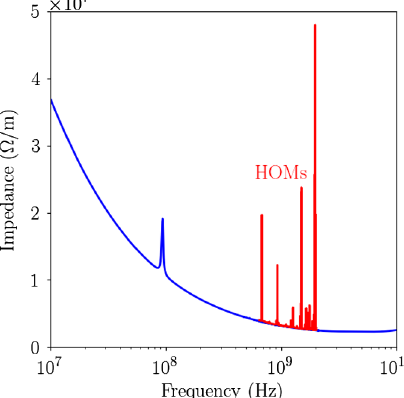
modes.FIG. 1. Higher order modes of the crab cavities (shown in red) dominate the HL-LHC transverse impedance (blue line) at the frequencies around 1 GHz. Real part of the horizontal dipolar impedance is plotted vs frequency for the ultimate scenario at the top energy of E ¼ 7 TeV. β (cid:1) ¼ 41 cm, 4 cavities per IP and